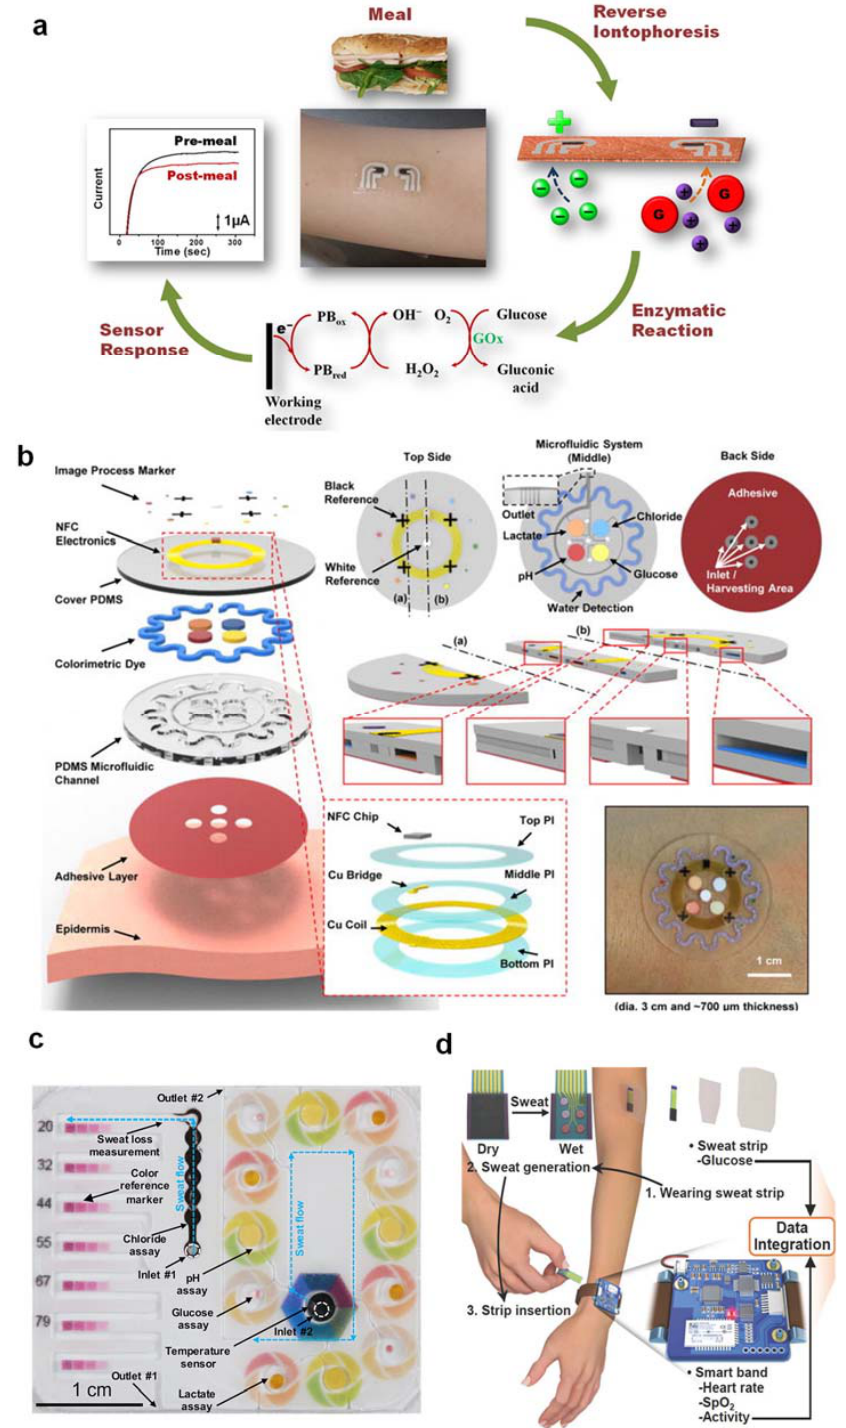
Figure 1. ( a ) A tattoo-based glucose-sensing platform that is non-invasive. ( b ) Schematic illustrations, optical images, and theoretical stress modeling of an epidermal microfluidic biosensor for sweat monitoring integrated with flexible electronics. ( c ) Soft, flexible microfluidic devices for colorimetric sweat analysis on the skin. ( d ) Schematic diagram of a wearable health-monitoring device consisting of a disposable sweat test strip for measuring glucose and a wearable smart band for monitoring heart rate, blood oxygen saturation, and physical activity. The figures are reprinted with permission from ref [3–5,10] .